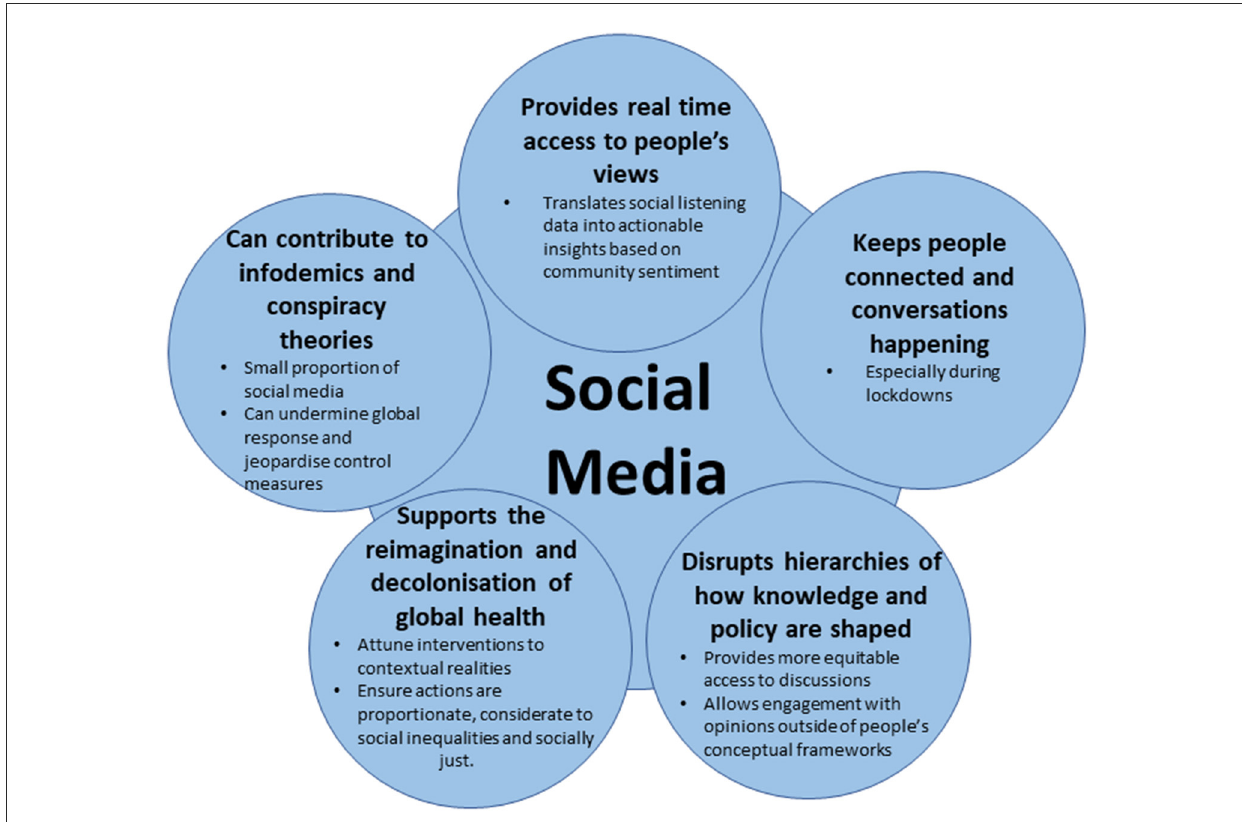
FIGURE1 Social media during a pandemic.